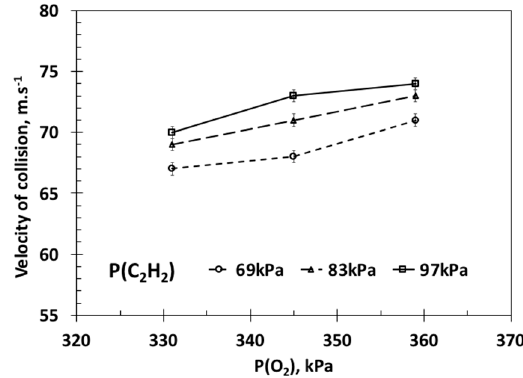
Figure 1. Results of Collision Speed vs. Gas feed pressure. Values obtained from Jet & Poudres software. Table 1. Experimental feed pressure levels and velocity of collision obtained from simulation.